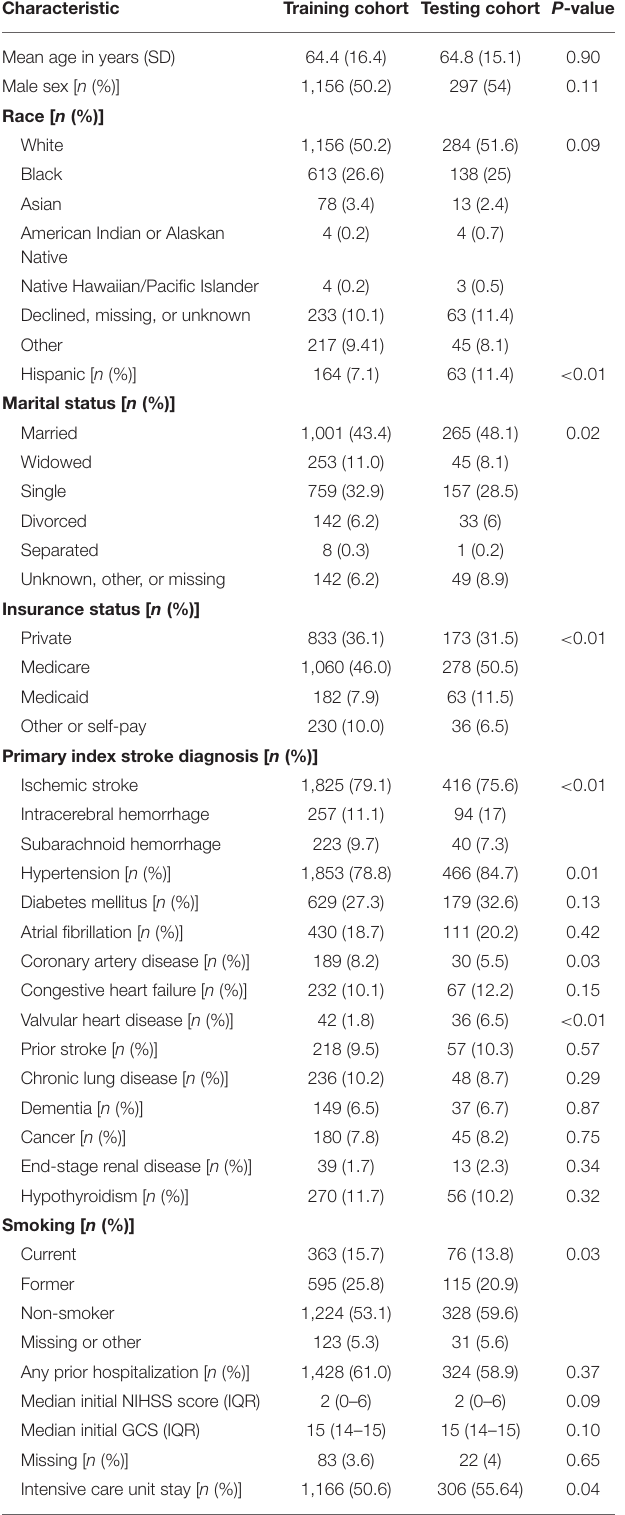
TABLE 2 | Baseline characteristics of the training cohort ( n = 2,305) and testing cohort ( n = 550).